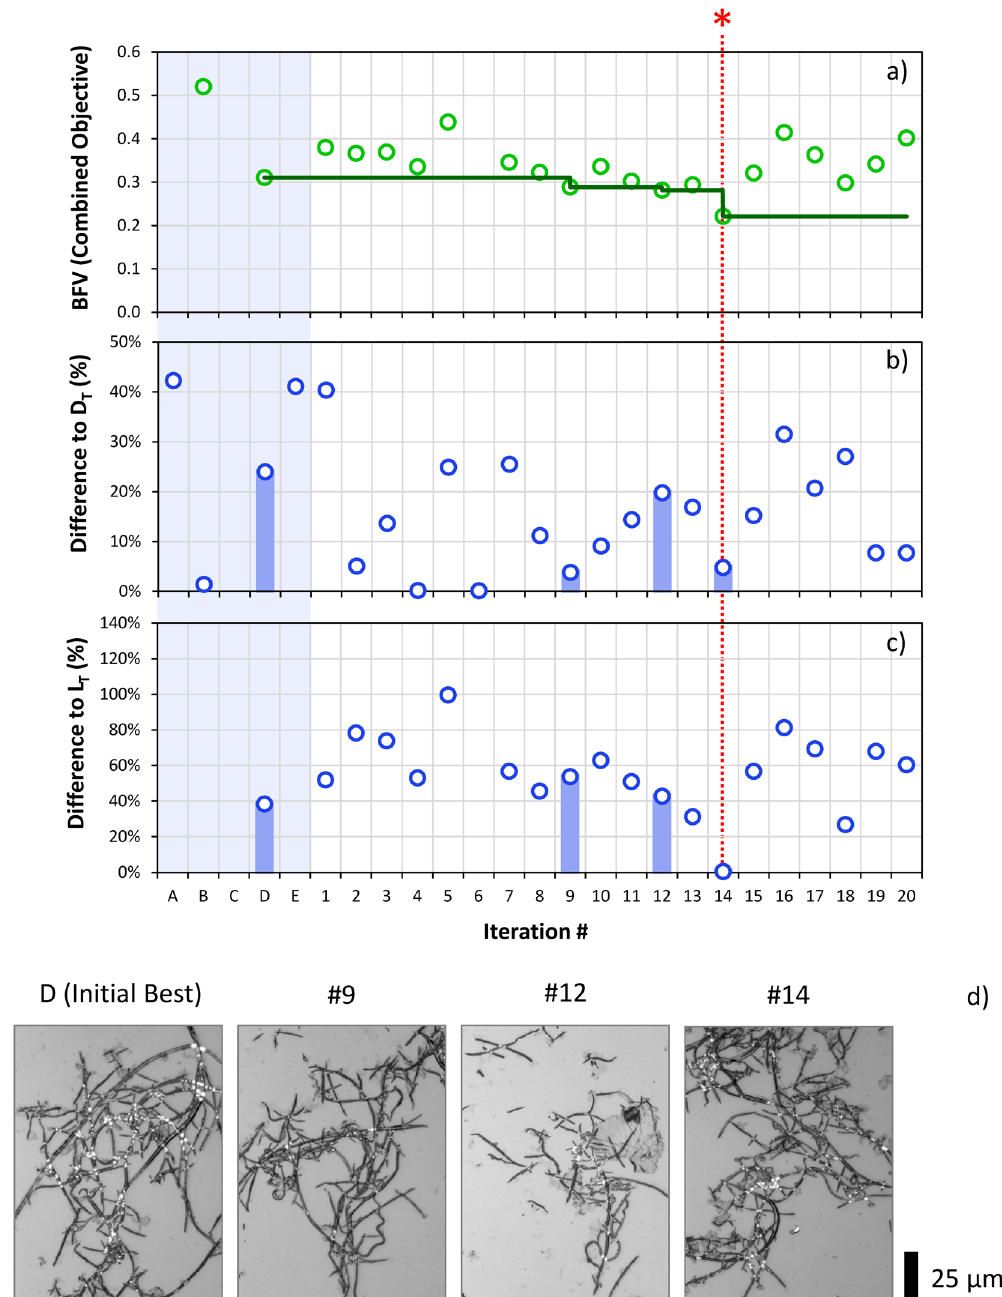
Figure 4. The results of a Run 1, starting from random samples for Target 1 (L = 70 μ m, D = 1 μ m). ( a ) shows the Best Found Value (BFV) of the combined objective for iterations of the optimisation process. The vertical axis is the dimensionless combined objective, in the range 0 to 1. Lower values are better. The horizontal axis shows iteration number; Samples A–E represent the 5 initial random samples. The value at each iteration is indicated by a circle. ( b ) − L L L / , the magnitude of the deviation in found length L from the target L T T percentage of the target L . ( c ) − D D D / , the magnitude of the deviation in found diameter D from the T T T target D , as a percentage of the target D . These two figures show how closely the BFV is satisfying the specified T T target criteria. The vertical bars correspond to the deviations in length and diameter at point where the BFV improves. ( d ) The corresponding SPF optical microscope images. The red asterisk ( * ) and dashed line indicates the optimal settings identified in the iterations